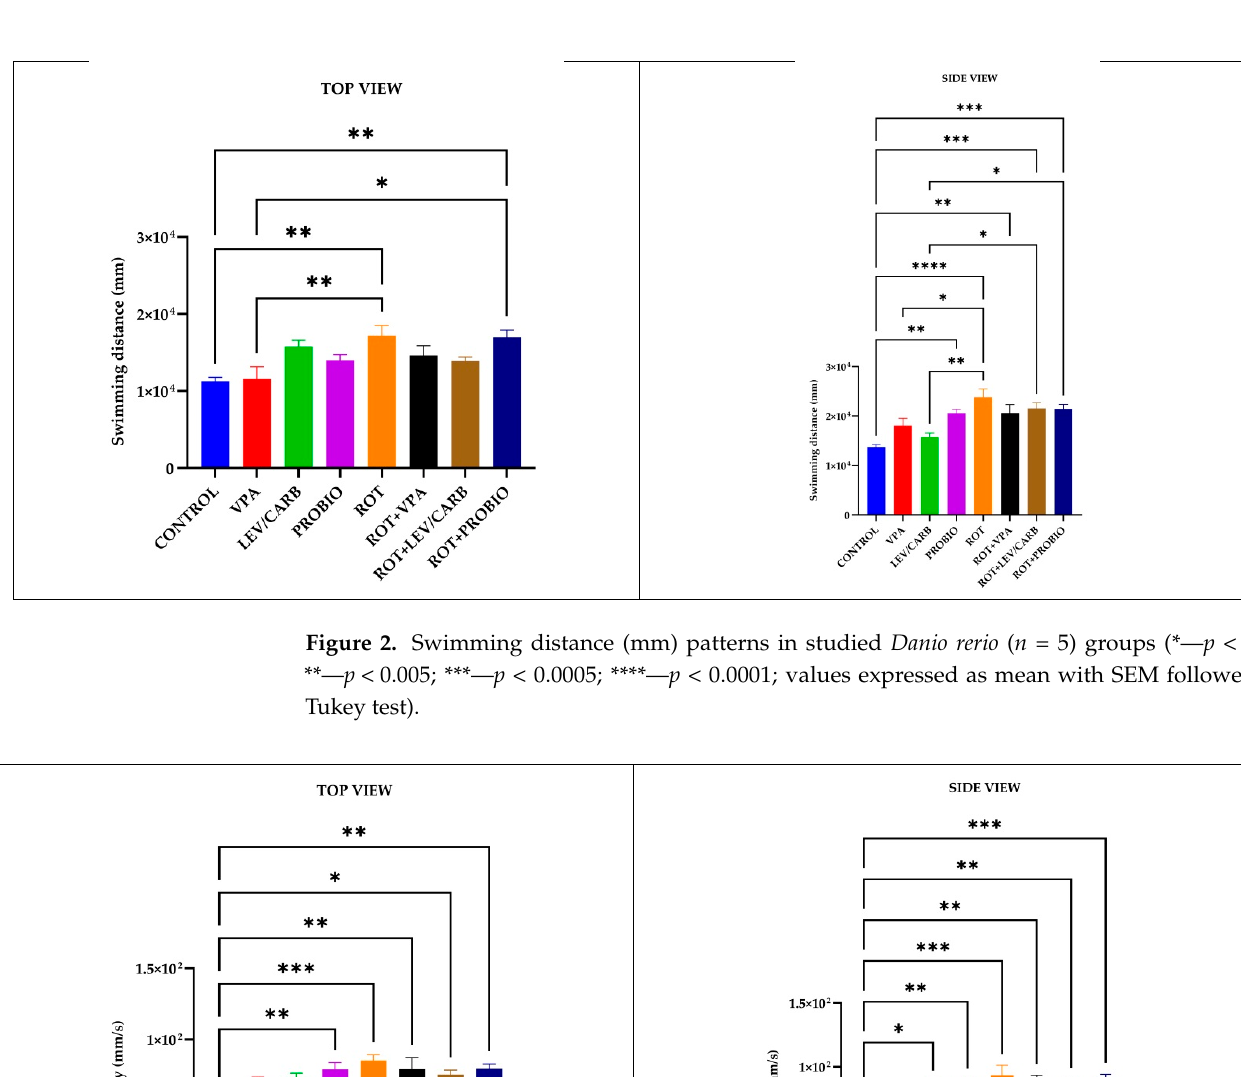
Figure 4. Episodes of inactivity (s) patterns in studied Danio rerio ( n = 5) groups (*— p < 0.05; **— p < 0.005; ***— p < 0.0005; values expressed as mean with SEM followed by Tukey test). 3.2. ROT Causes a Reduction in Neurogenesis and Triggers Apoptosis in Exposed Zebrafish At the level of the optic tectum in the (a) CONTROL group, a moderate marking based on the immunohistochemical (IHC) markers used was observed. PCNA marks two small areas of neuronal stem cells (NSCs) and neuroblasts, respectively.